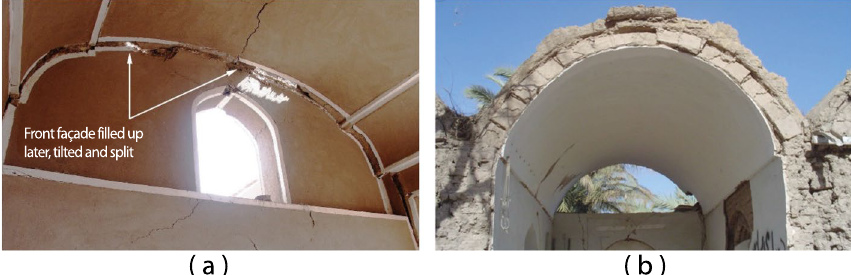
Fig. 24 Out‑of‑plane failure modes of adobe vaults during the Bam earthquake: ( a ) tilting and splitting of a front façade and ( b ) overturning of both gable walls, although the vault remained standing (Source: Maïni and Davis